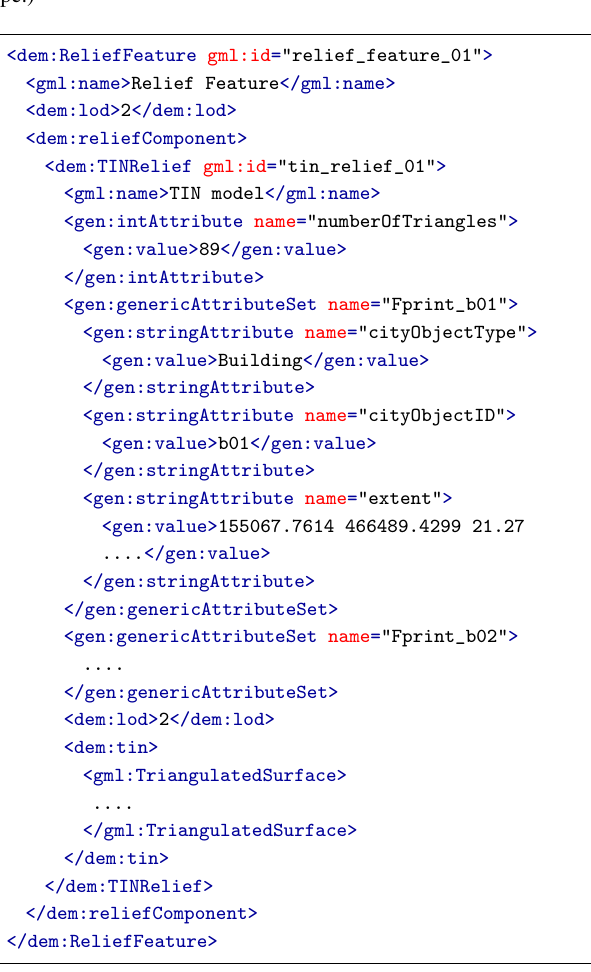
Figure 4. Terrain models at different LODs (0-3) according to our framework. (Source: Generated by our Random3DTerrain software